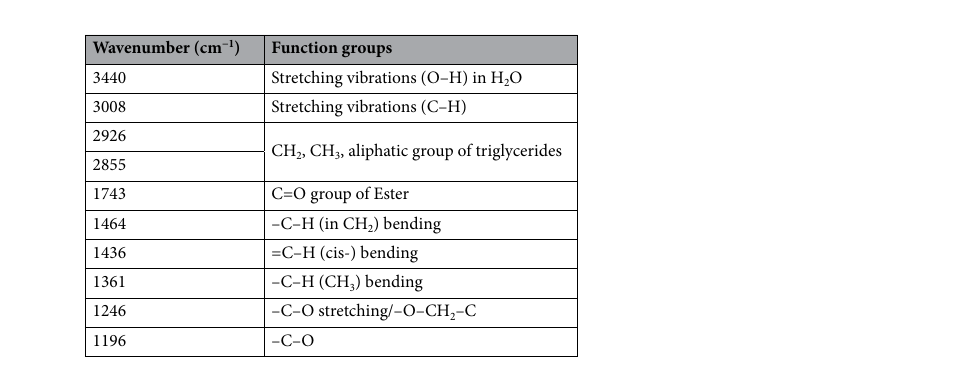
Table 6. FTIR Analysis of the functional group of FAME produced from cooking oil waste lipase transesterification and esterification process.